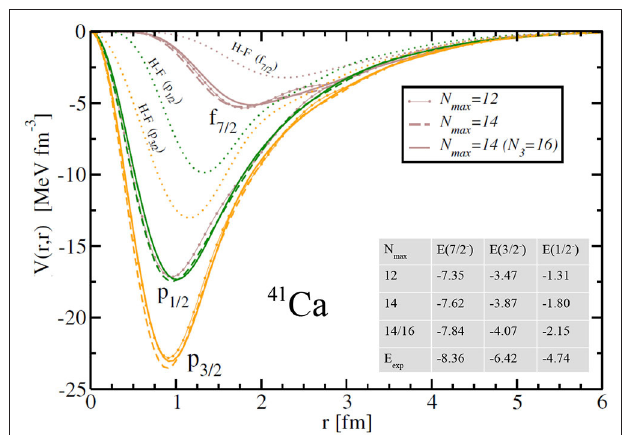
FIGURE 2 | Diagonal part of the n + 40 Ca optical potential for the bound states in 41 Ca computed with the NNLO sat interaction. Results are shown for several values of N max and the corresponding bound state energies (with respect to the 40 Ca ground state) are shown in the table (in MeV). The components of the HF potential in the associated partial waves are shown for ( N max , N 3 ) = (14,16) (see text for